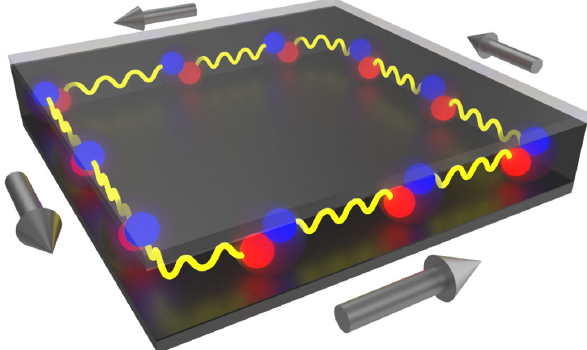
FIG. 1. Schematic view of a system with topological polaritons. A chiral polaritonic mode consisting of a mixture of bound particle-hole pairs (excitons) and photons is found at the edge of the